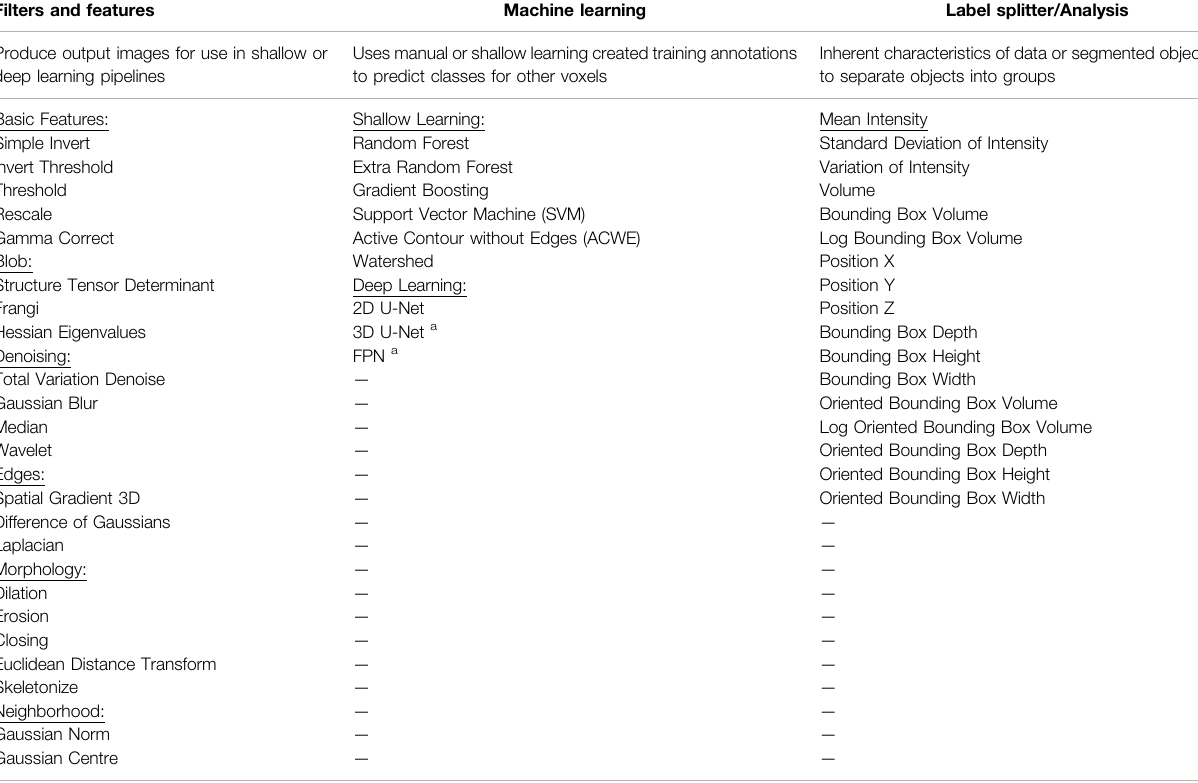
TABLE 1 | List of all fi lters/features, shallow and deep learning, and label splitter/analysis options within SuRVoS2. Filters and features Machine learning Produce output images for use in shallow or Uses manual or shallow learning created training annotations deep learning pipelines to predict classes for other